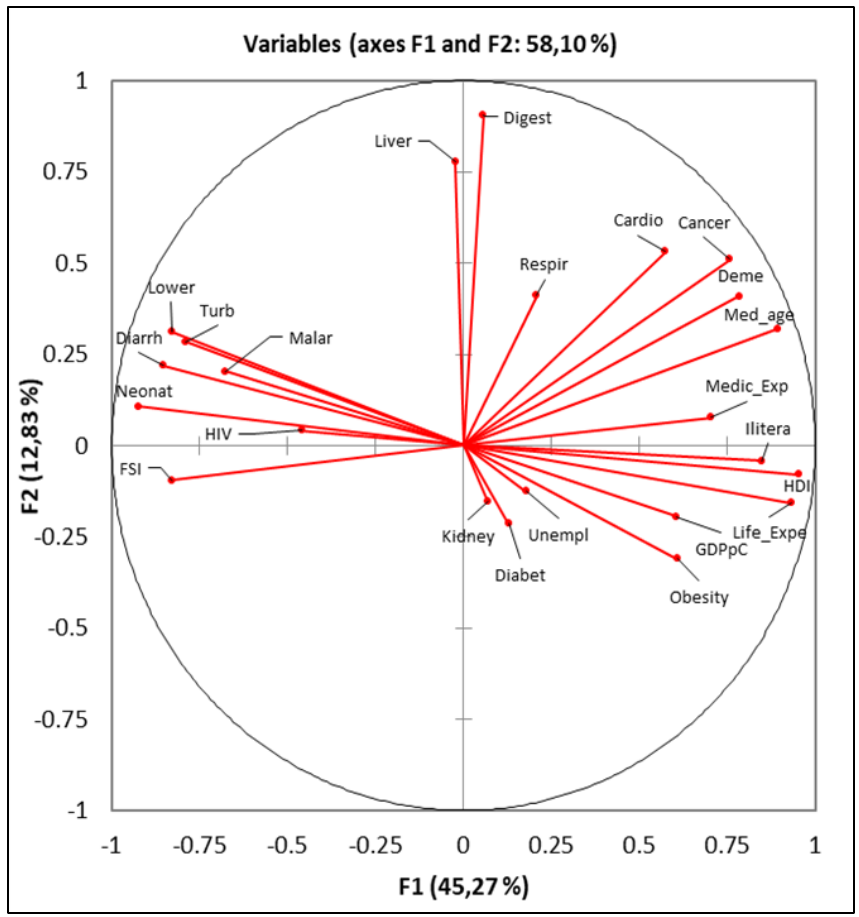
Figure 7. Principal component analysis (PCA) results. Source of data: The Institute for Health Metrics and Evaluation, World Bank.